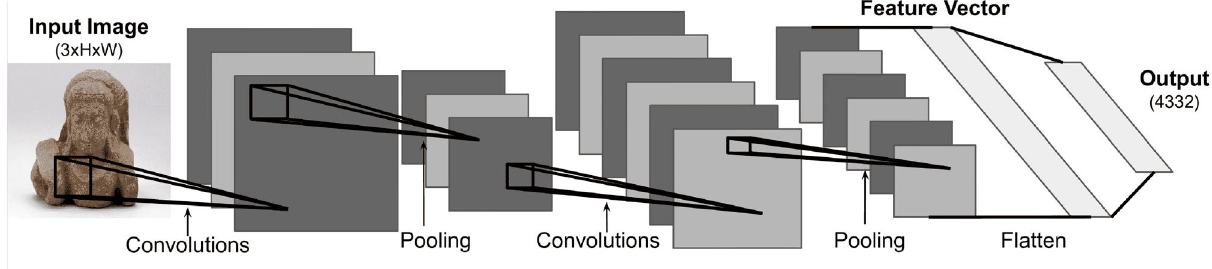
Figure 1. CNN architecture with an RGB image input and desired outputs representing votes for objects in of our instance classification